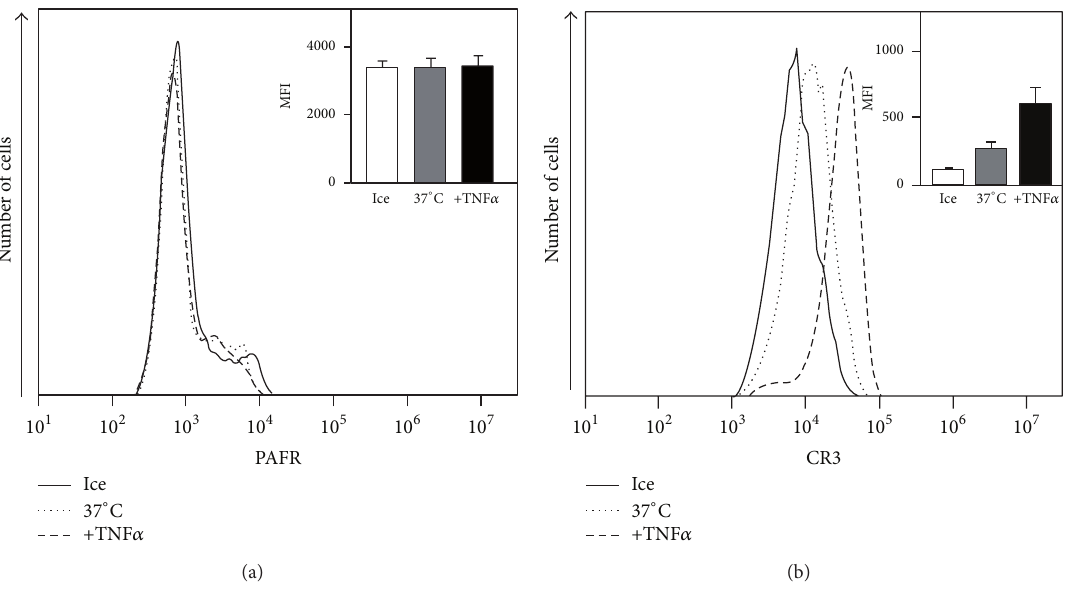
Figure 2: TNF- 𝛼 induced receptor mobilization does not involve the PAFR. Human neutrophils (5 × 10 5 ) were incubated on ice (solid lines), or at 37 ∘ C without additive (dotted lines), or with TNF- 𝛼 (10ng/mL; dashed lines) for 20 min. The cells were then fixed with 2% ice-cold paraformaldehyde and labeled with specific antibodies against PAFR (A) or complement receptor 3 (CR3; B). Surface receptor expression was determined by flow cytometry, and a representative histogram is shown. Abscissa: fluorescence intensity; Ordinate: number of cells. The insets show the mean fluorescence intensity (MFI) ± SEM ( 𝑛 = 5 ).